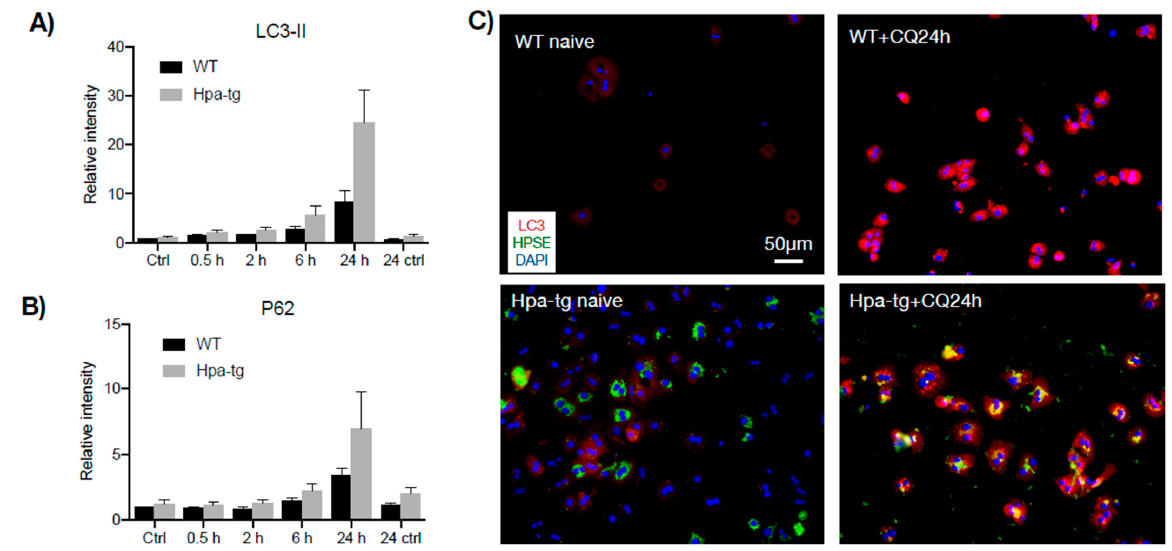
Figure 7. Autophagy in response to chloroquine. Hepatocytes isolated from naïve mouse liver were treated with chloroquine (CQ) to a final concentration of 20 µM and the cell lysates were subjected to Western blot analysis. ( A ) Quantification of LC3-II and ( B ) P62 levels (Western blot, Supplementary Figure S5) in cell lysates prepared at the indicated time points (20 µg total protein/lane). Band intensity was quantified by Image Lab software and the naïve WT value was set arbitrarily to a value of 1 (each bar represents the average band intensity; n = 5 mice per group). ( C ) Immunostaining of hepatocytes before and after CQ treatment. Note merged signals of LC3 and heparanase in the Hpa-tg cells.